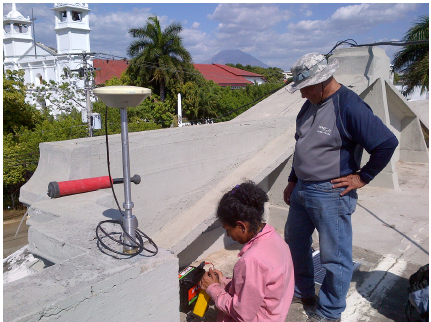
Figure A4. Close-up of the self-centering mount at the Usulutan site and training of the MARN personnel in the